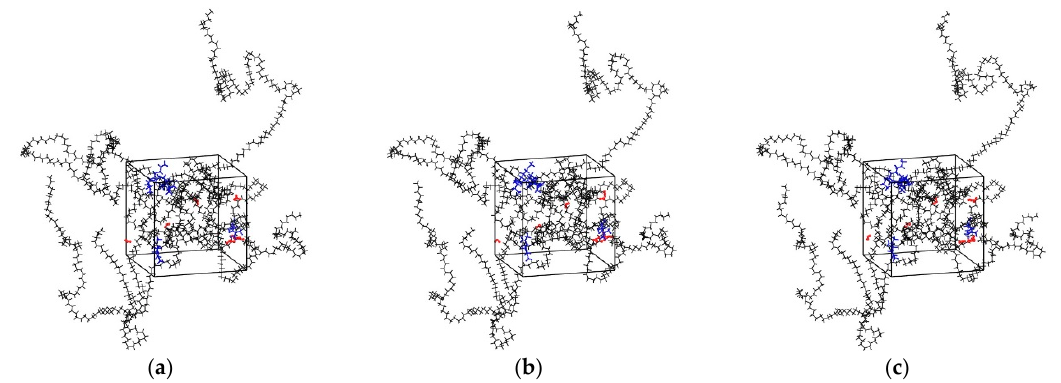
Figure 2. Snapshots of the simulation boxes at different simulation time (black: PE; red: H 2 O molecules; blue: Flavor molecules). ( a ) t = 0; ( b ) t = 50 ns; ( c ) t = 100 ns.